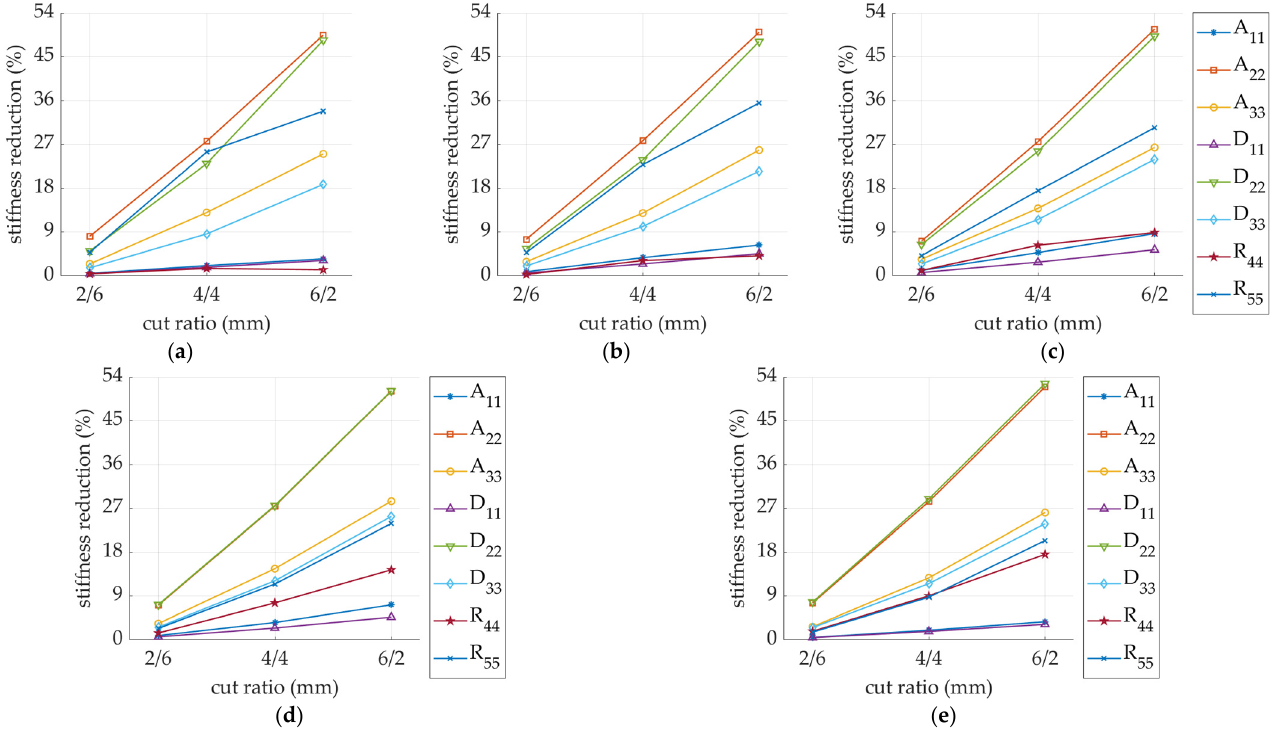
Figure 13. Stiffness degradation in sample SW: ( a ) F-15; ( b ) F-30; ( c ) F-45; ( d ) F-60; ( e ) F-75. Three types of perforations were analyzed (2/6 mm, 4/4 mm, or 6/2 mm).